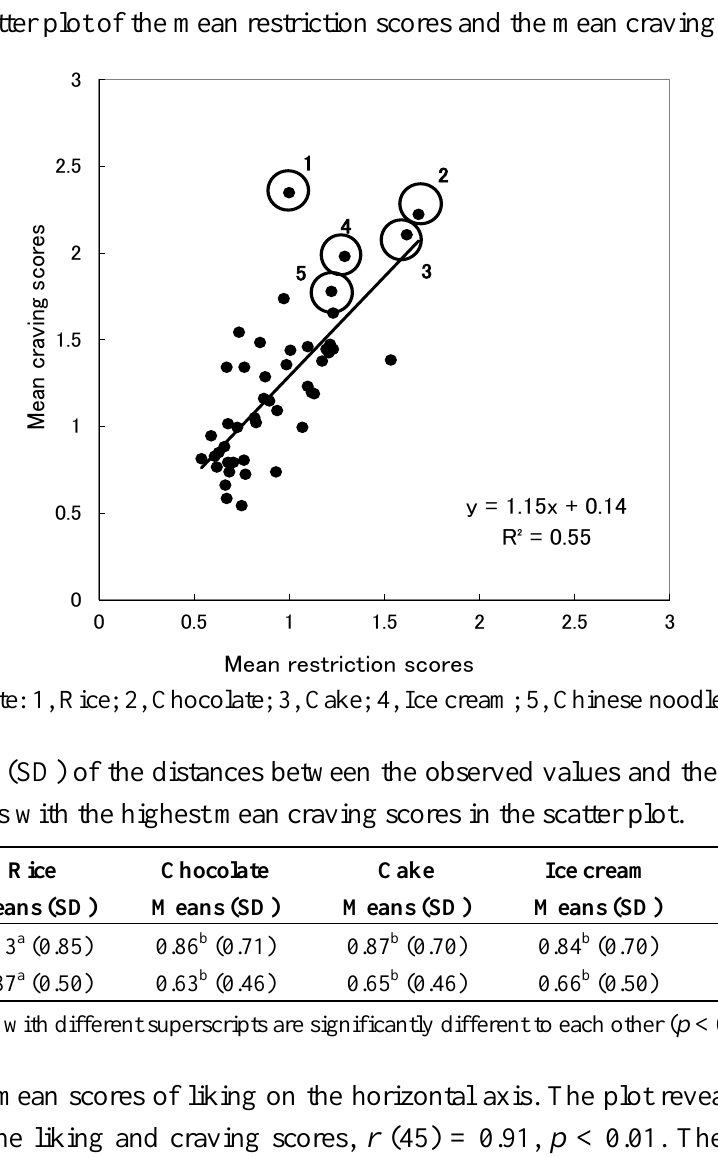
Figure 1. Scatter plot of the mean restriction scores and the mean craving scores.